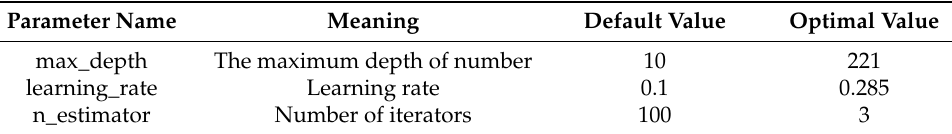
Table 3. Optimal parameters of